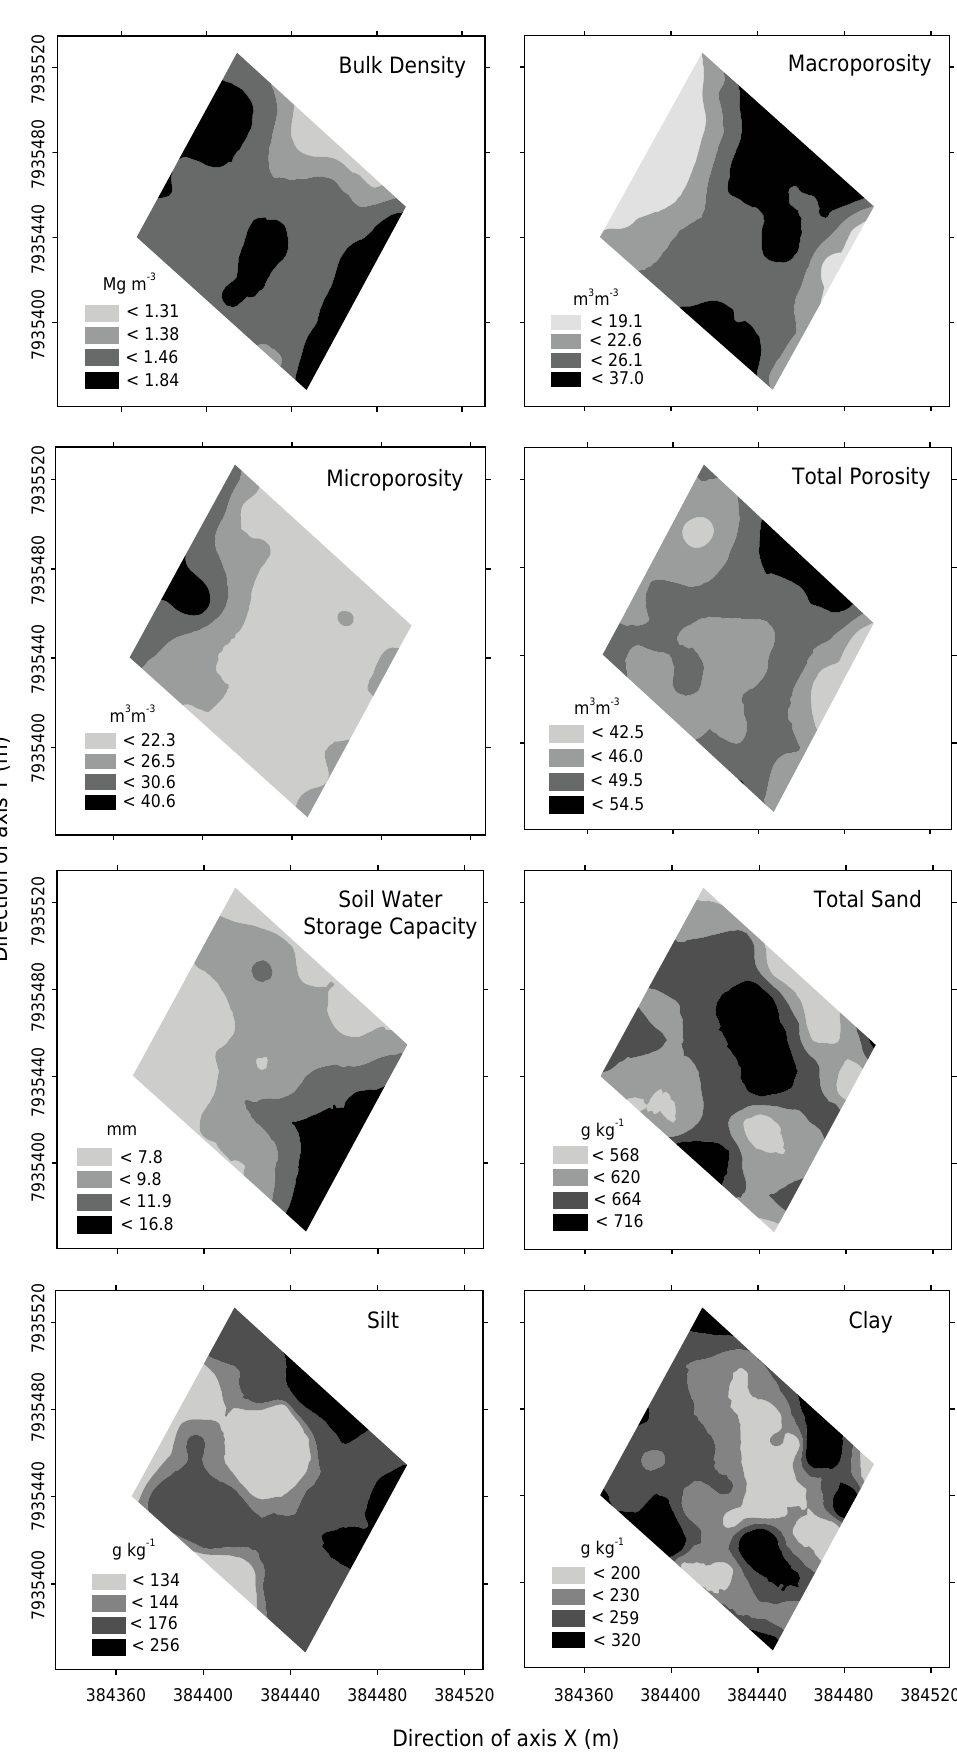
Figure 4. Interpolated soil maps for soil density, soil macroporosity and microporosity, total porosity, soil water storage capacity, and total sand, silt, and clay in a Conilon coffee